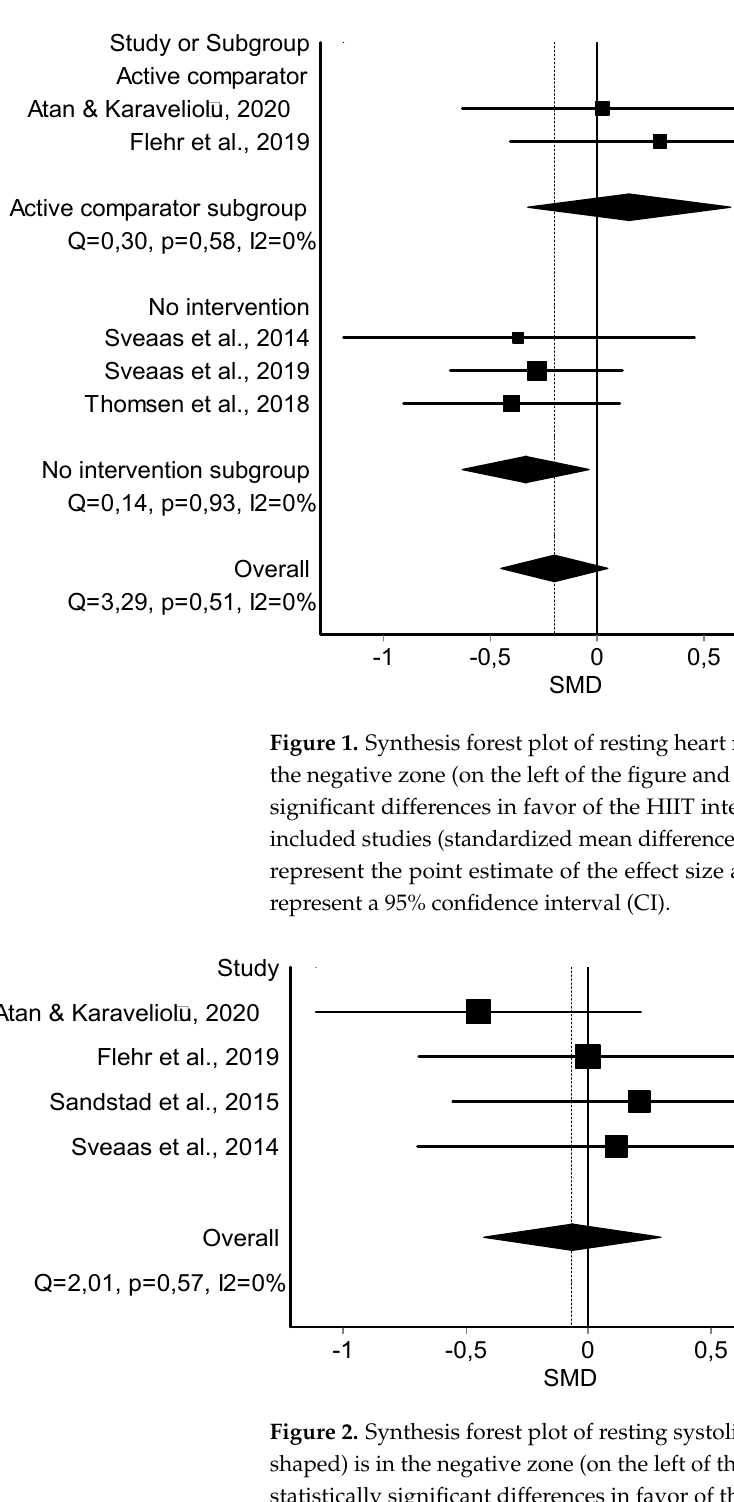
Figure 2. Synthesis forest plot of resting systolic blood pressure variable. If the diagram (diamond- shaped) is in the negative zone (on the left of the figure and without touching the 0 line), it indicates statistically significant differences in favor of the HIIT intervention. The forest plot summarizes the results of included studies (SMD and weight). The small boxes with squares represent the point estimate of the effect size and sample size. The lines on either side of the box represent a 95% CI. Resting Diastolic Blood Pressure Variable The meta-analysis showed no statistically significant differences in the resting dias- tolic blood pressure in four studies [38,39,42,45] ( n = 119; SMD = 0.07; 95% CI: − 0.29, 0.44; heterogeneity Q value: 1.81; p = 0.61; I 2 = 0%) showing no heterogeneity (Figure 3). The visual evaluation of the funnel and Doi plot showed no asymmetry (LFK index = − 0.02) (Appendix A).